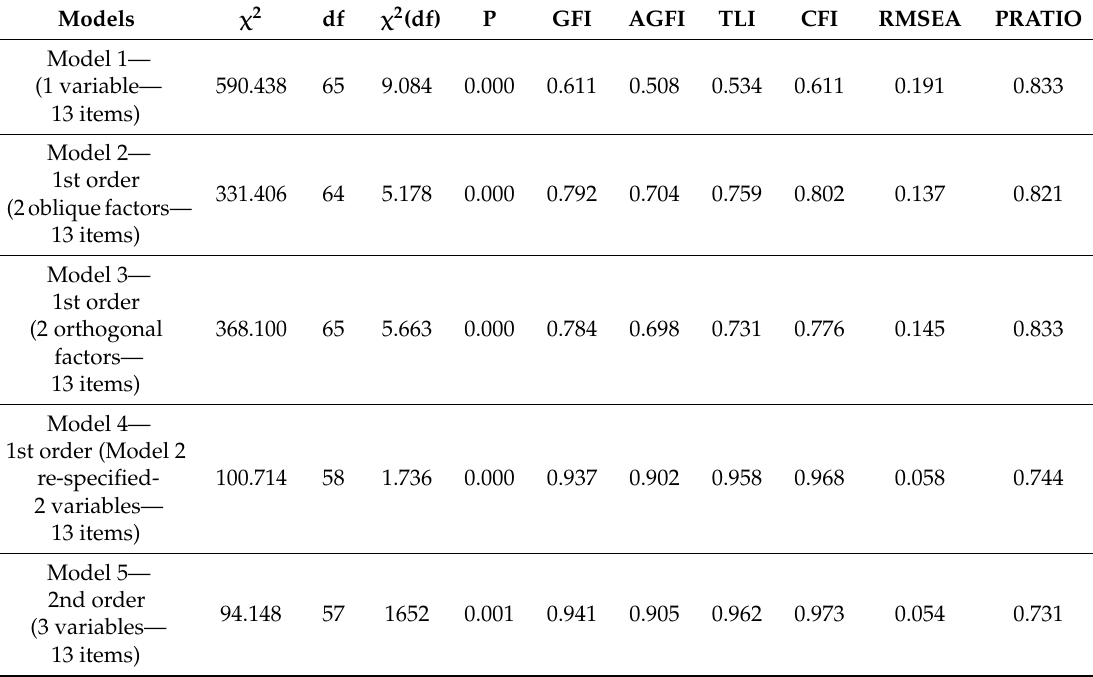
Table 3. Fit Index for Empowerment